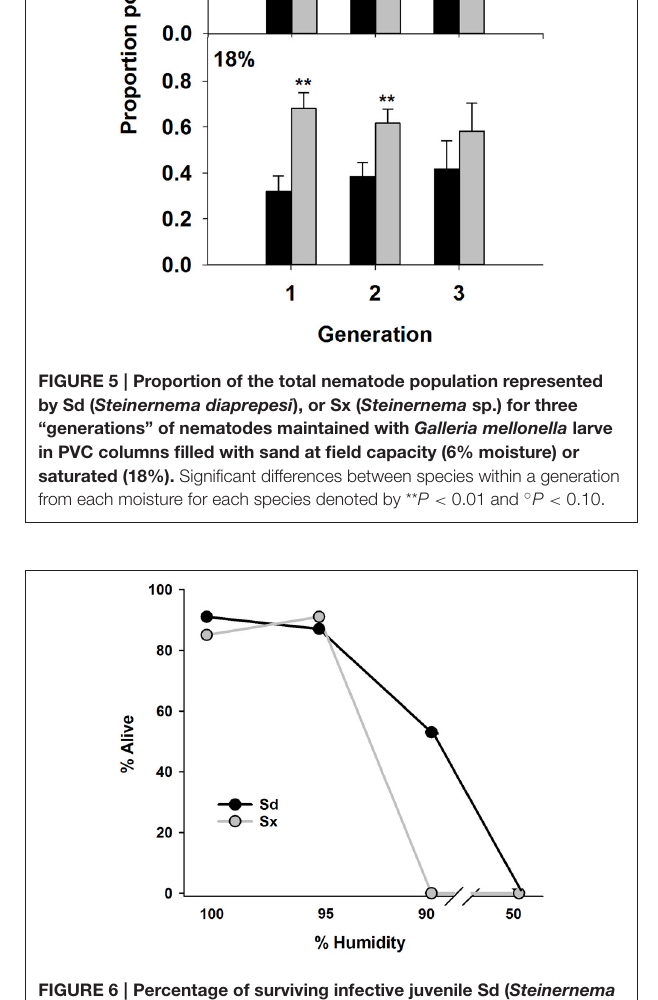
FIGURE 6 | Percentage of surviving infective juvenile Sd ( Steinernema diaprepesi ) or Sx ( Steinernema sp.) after 24 h storage at 100, 95, 90, or 50% relative humidity. Humidity conditions were created by floating Petrie dish lids containing filter paper and EPNs on either tap water or glycerol solutions in sealed